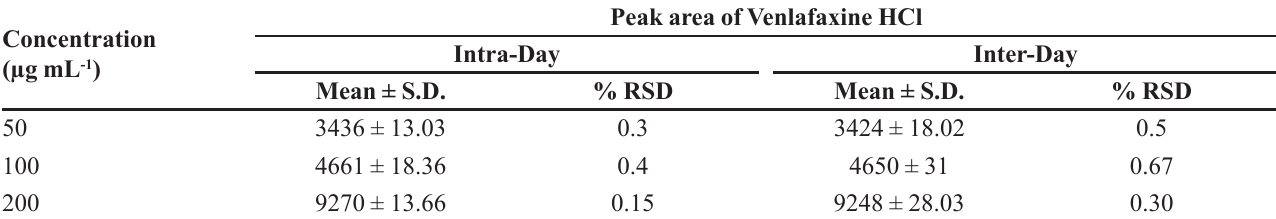
TABLE III - Intra-day and inter-day precision data for quantification of venlafaxine HCl